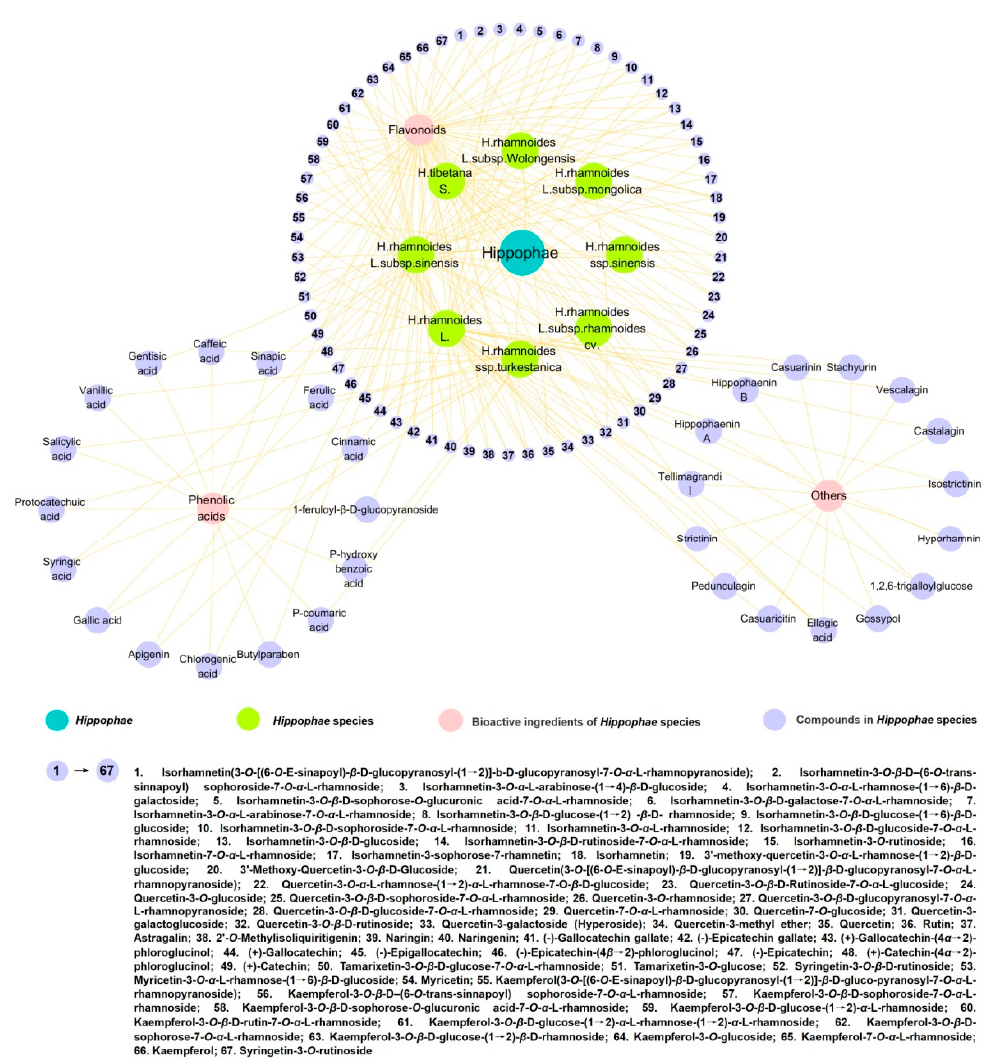
Figure 2. Polyphenolic compounds from the Hippophae species.